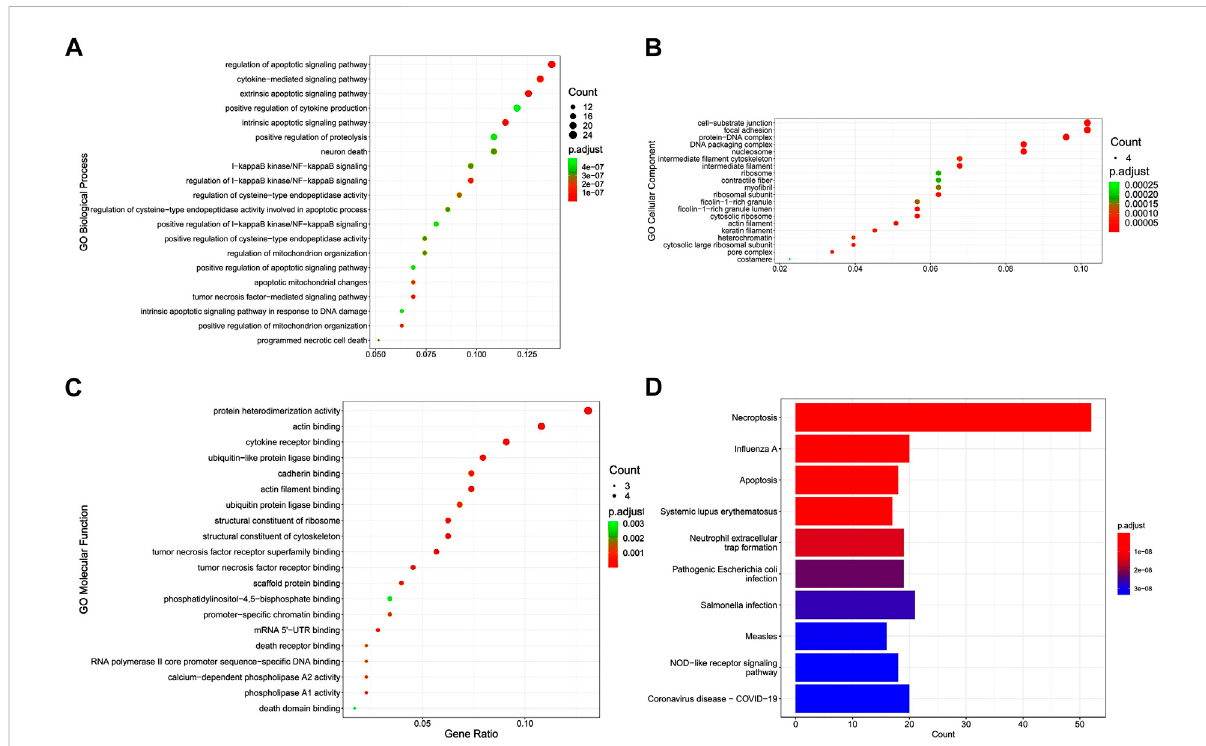
FIGURE 3 Gene Ontology (GO) and Kyoto Encyclopedia of Genes and Genomes (KEGG) enrichment analysis of differentially expressed necroptosis- related genes (DENRGs). GO enrichment of DENRGs for (A) biological processes, (B) cellular components, and (C) molecular functions. (D) KEGG enrichment of